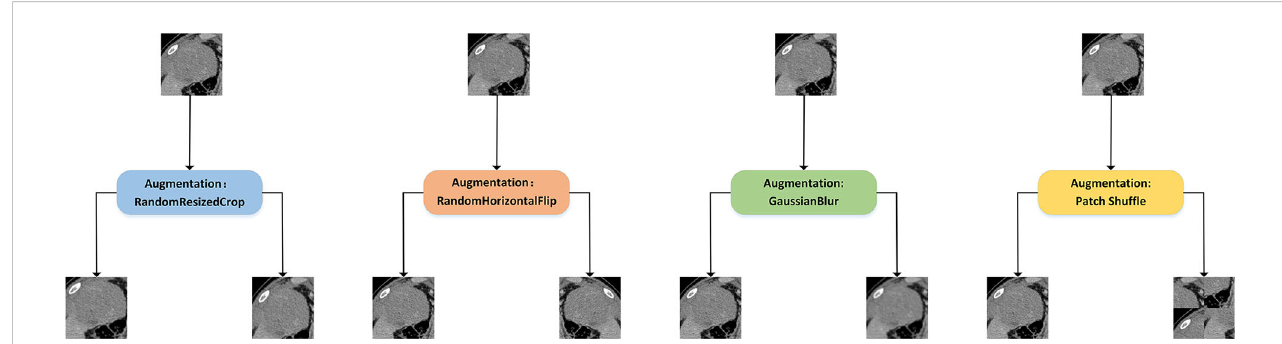
FIGURE 3 Illustration of different data augmentation strategies for contrastive learning. Random Resized Crop would crop a random part of the image and resize it to a uniform size. Random Horizontal Flip would randomly fl ip the image horizontally. GaussianBlur would randomly blur the image with Gaussian noise. In addition, we introduced the patch shuf fl e strategy that divided the image into four patches and randomly put the four patches together to deepen the model ’ s understanding of the local